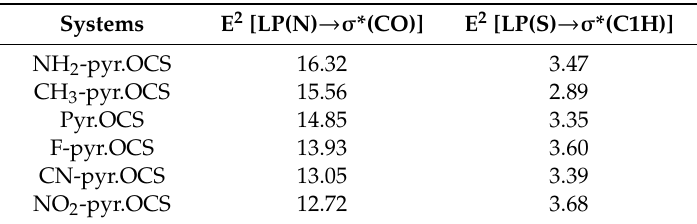
Table 8. Most important hyperconjugation energies (kJ / mol) in the B complexes between pyridines and